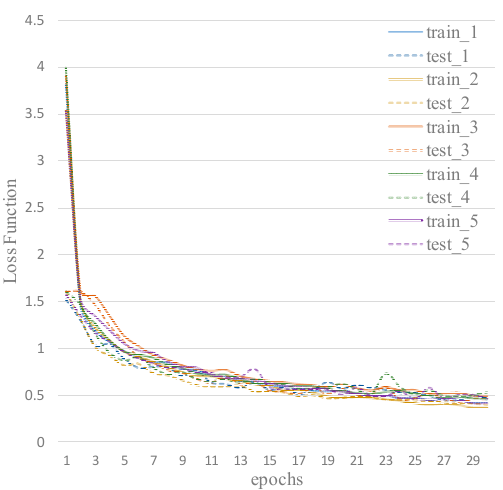
Figure 11. Five train–test categorical cross entropy (CCE) loss function graphs ( a – e ) of five motor loading conditions, respectively, with five train–test runs of cross-validation.